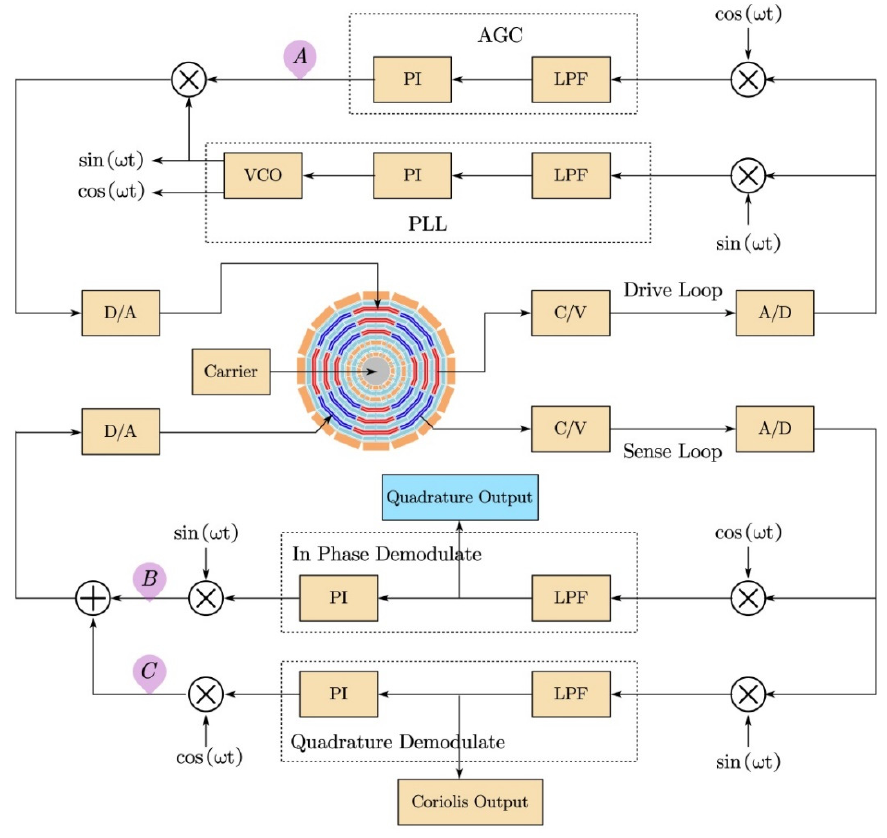
Figure 5. The diagram of the MEMS gyroscope circuit.